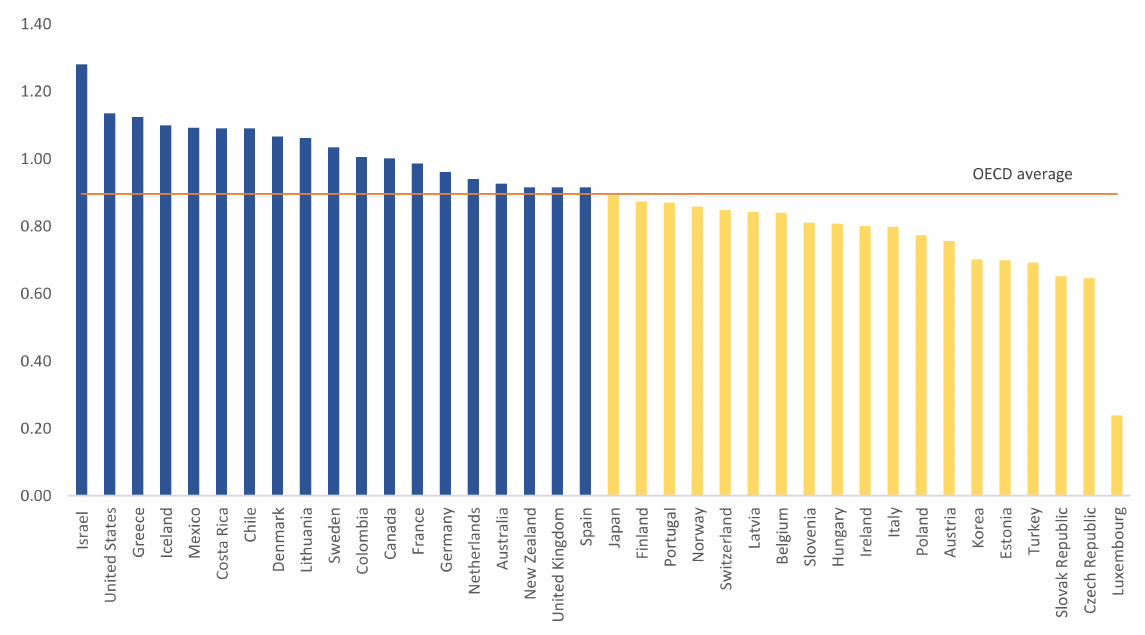
Figure 2. Capital productivity for the 38 OECD member